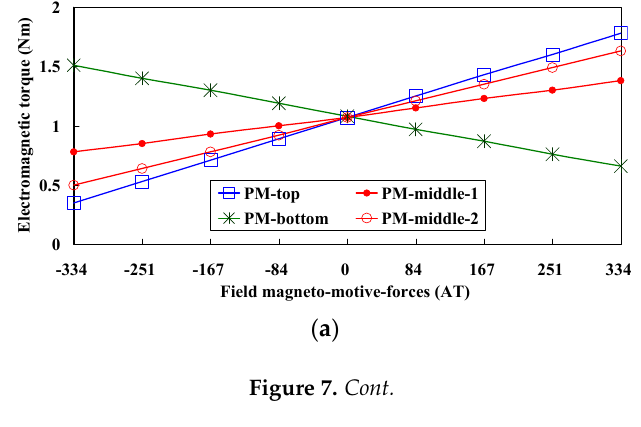
Figure 7. Cont. Figure 7. Cont.